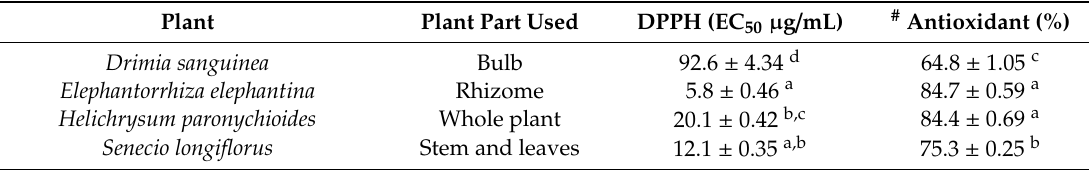
Table 2. Antioxidant activity [2,2-diphenyl-1-picryhydrazyl (DPPH) free radical scavenging and β -carotene-linoleic acid models] of 50% methanol extracts of four plants used by Batswana traditional health practitioners to treat skin